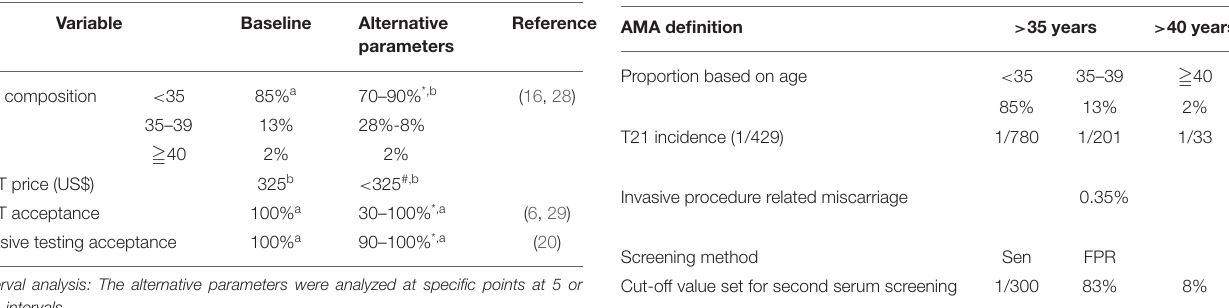
TABLE 2 | The summary of cost-effectiveness analyses related